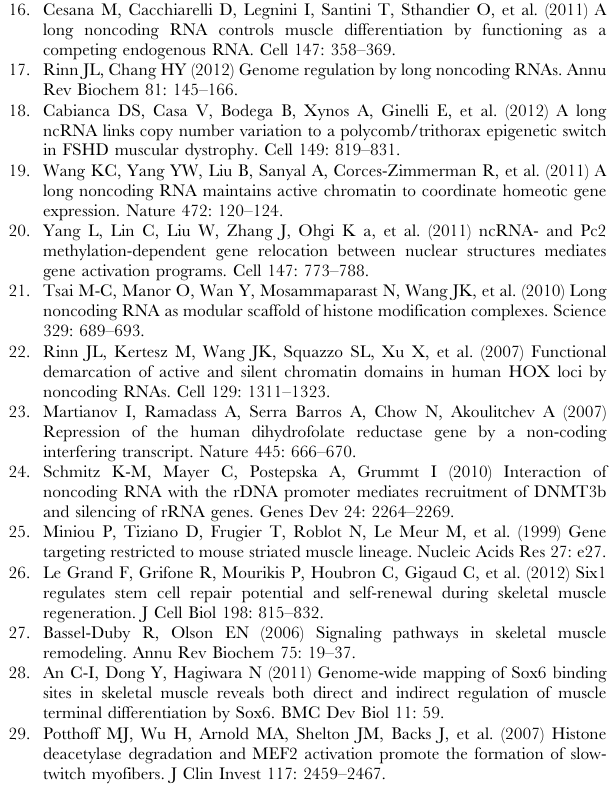
Figure S4 Immunostaining of MYH proteins. Immunostaining of MYH7 (red), MYH2 (red), MYH4 (red) and laminin (green) in TA of 12 weeks old control and cSix1KO male mice. Figure S5 Comparison between cSix1 mice and sh linc-MYH treated mice. ( A ) Venn diagram showing the overlap between genes that are up-regulated more than five fold in sh linc-MYH and two fold in cSix1 muscles. (p = 10 2 17 as given by a hypergeometric test). ( B ) Scatter plot of mRNA expression fold change (log2) as determined by microarray analysis of sh linc-MYH and cSix1 . Genes that are up-regulated more than five fold in sh linc-MYH and two fold in cSix1 muscles are indicated in red. ( C ) mRNA expression levels in sh linc-MYH knock-down and cSix1 TA muscles, as measured by qPCR experiments. Ctrl (means 6 SEM; n =4), cSix1 (means 6 SEM; n= 4), sh LacZ (means 6 SEM; n =5), sh linc- MYH (means 6 SEM; n= 5). ( D ) mRNA expression level of Ankrd1 , Zdbf2 and Peg10 in back muscles of cSix1 KO mice at E18.5, P2W, P4W and P8W, as determined by qPCR experi- ments, (means 6 SEM; n = 3 to 6 for each point). *P , 0.05, **P , 0.01, ***P , 0.001. Figure S6 MEF3 PWM used in this study. Table S1 Microarrays analysis of TA muscles electroporated by shRNA.